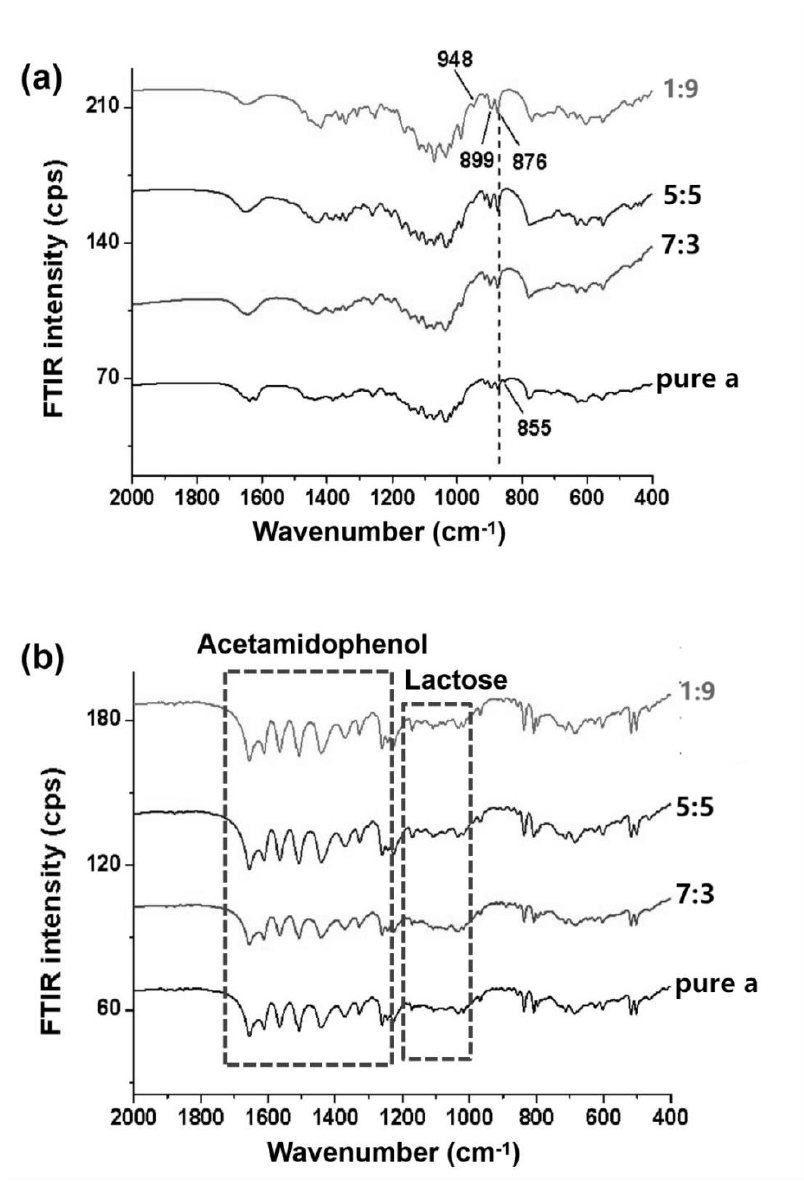
Figure 2. FTIR spectra of the pollen-like mesoporous lactose particles with α : β ratios of 1:0 (pure α ), 3:7, 5:5 and 1:9, ( a ) before and ( b ) after ingredient loading.